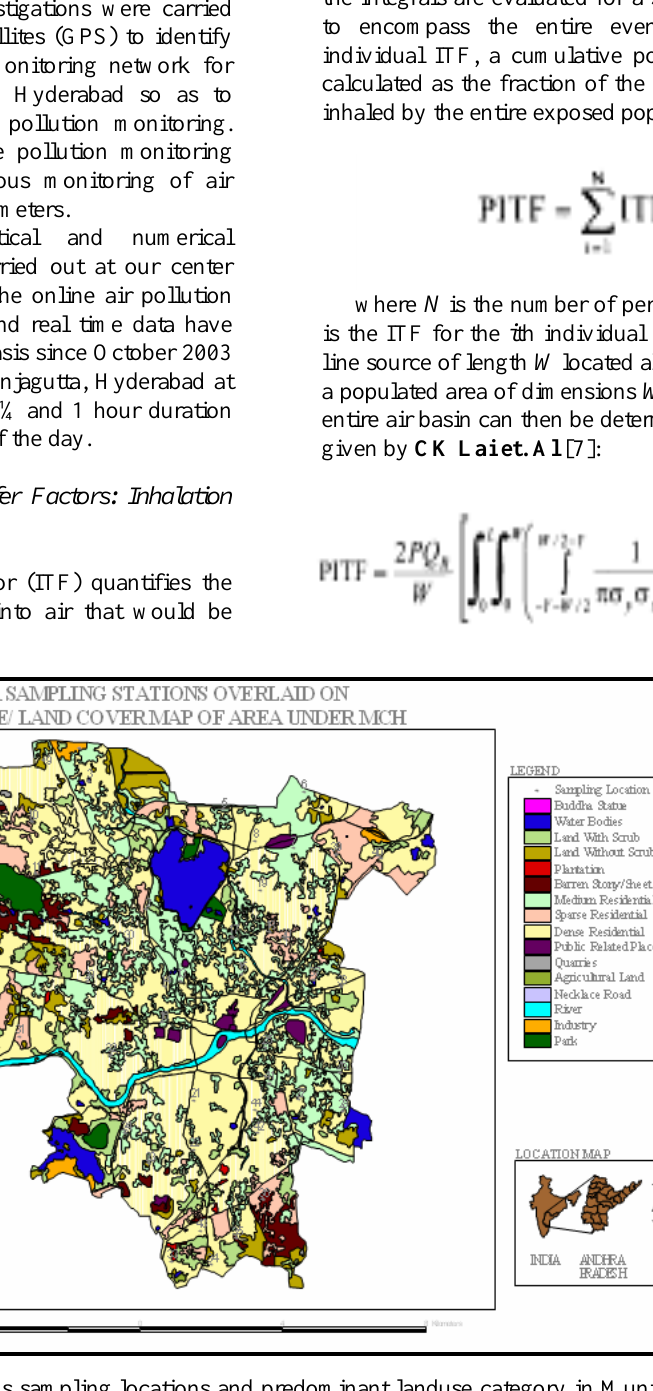
Figure 2: Various sampling locations and predominant landuse category in